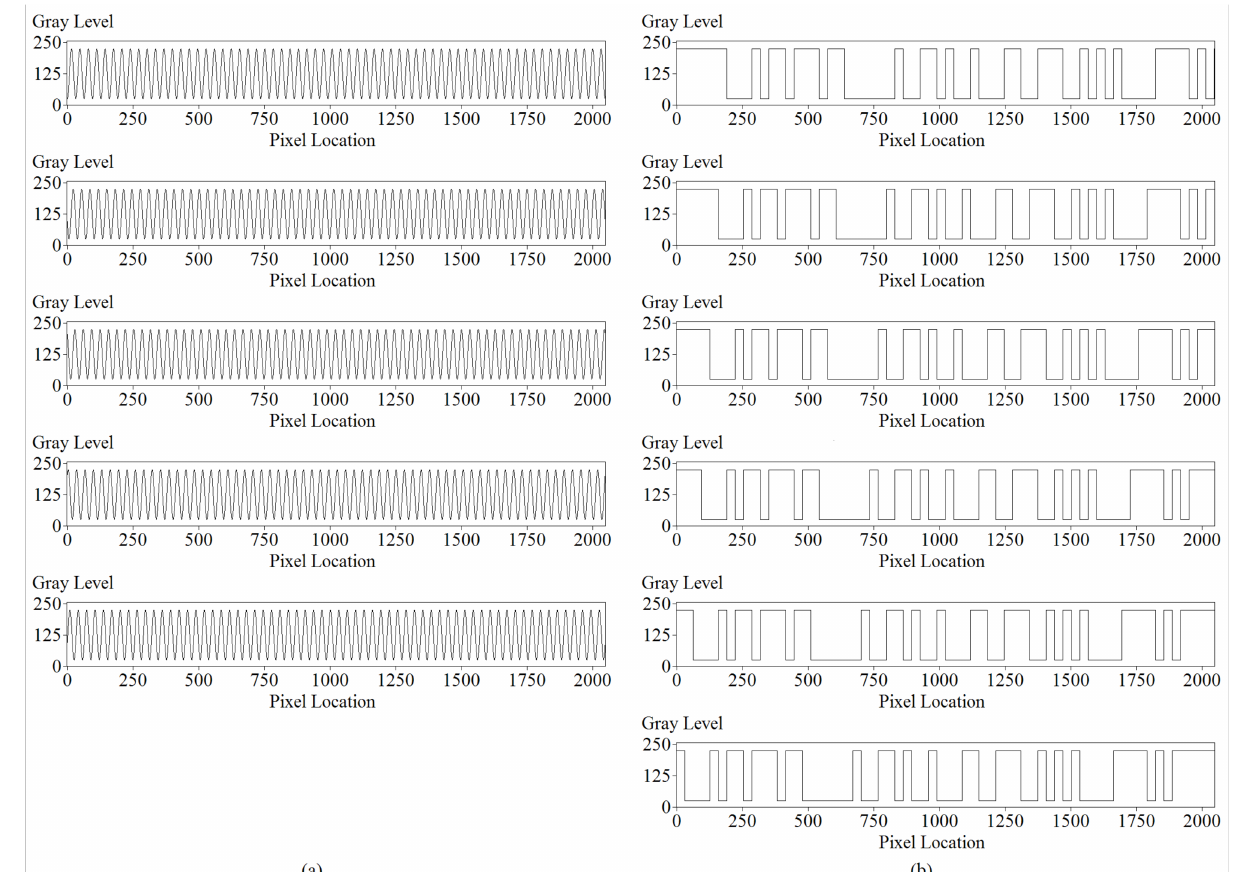
Figure 11. ( a ) The 1D gray-level distributions of the five sinusoidal patterns. ( b ) The 1D gray-level distributions of the six binary patterns.